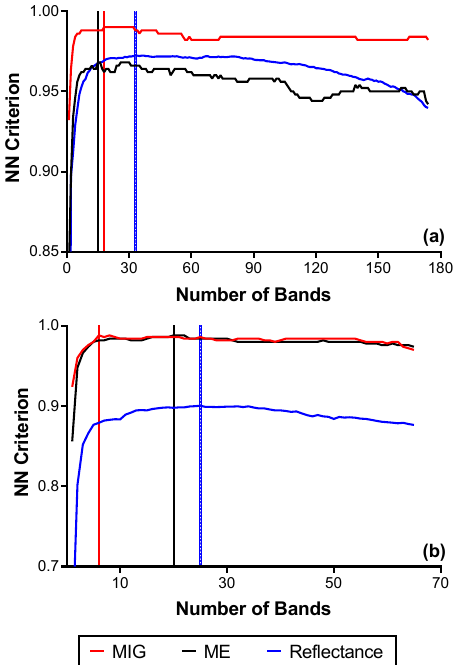
Figure 7. Results from the forward feature selection (FFS) implemented on reflectance and SCM data with the highest NN criterion values: ( a ) VNIR reflectance (2.5 m), MIG–VNIR (250 m), and ME–VNIR (250 m); ( b ) SWIR reflectance (2.5 m), MIG–SWIR (62.5 m), and ME–SWIR (62.5 m).